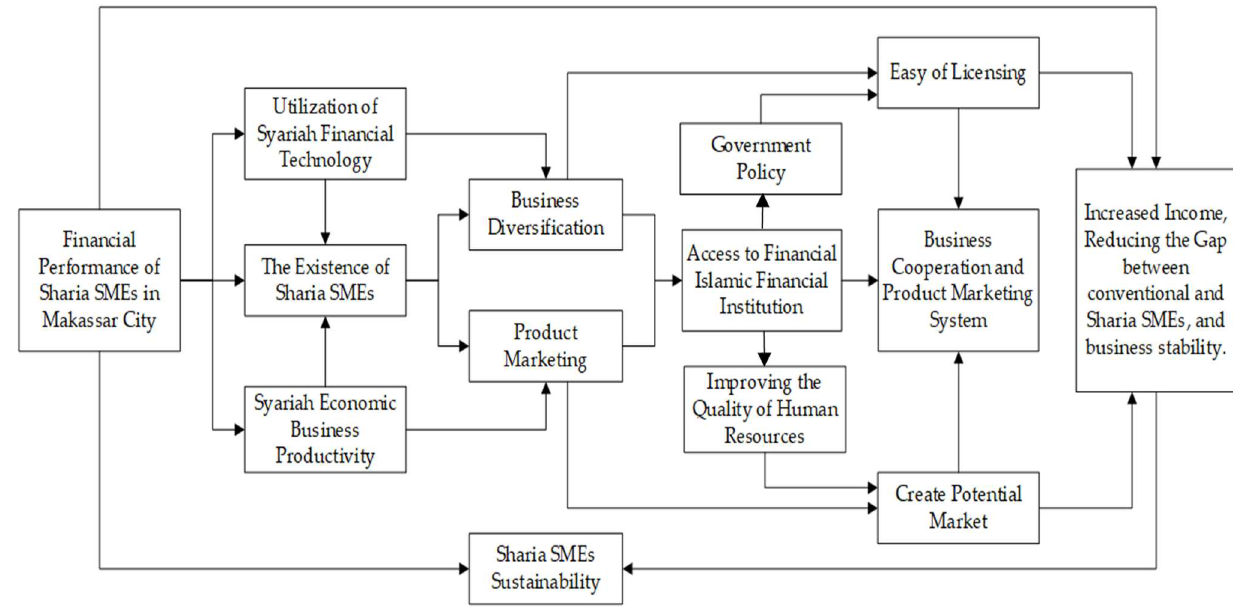
Figure 1. The research framework of financial performance and sustainability of sharia SMEs. Source: Authors’ elaboration.